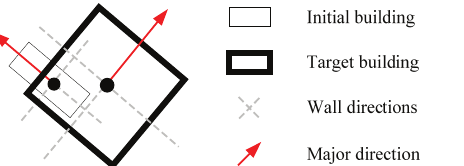
Figure 2: Initial and correspondence buildings with strong and weak major directions